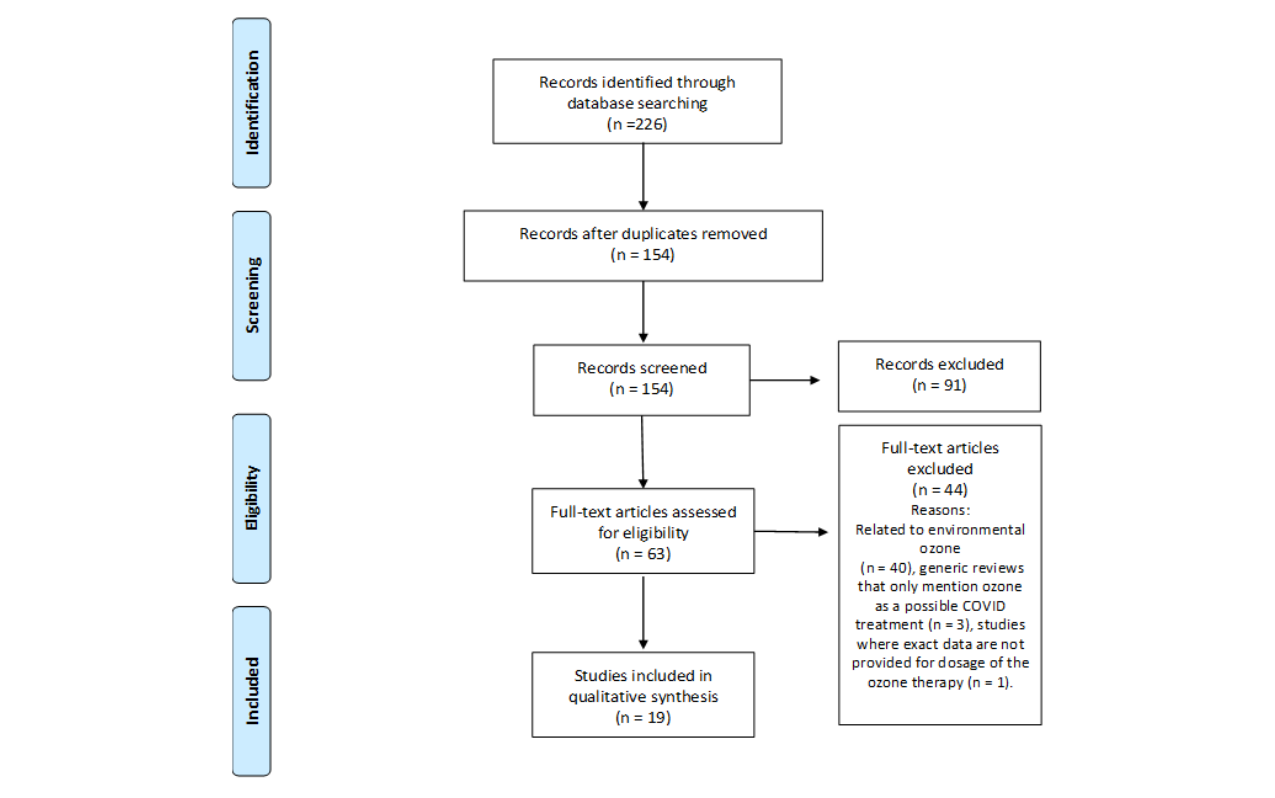
FIGURE 1 - Flowchart of the systematized